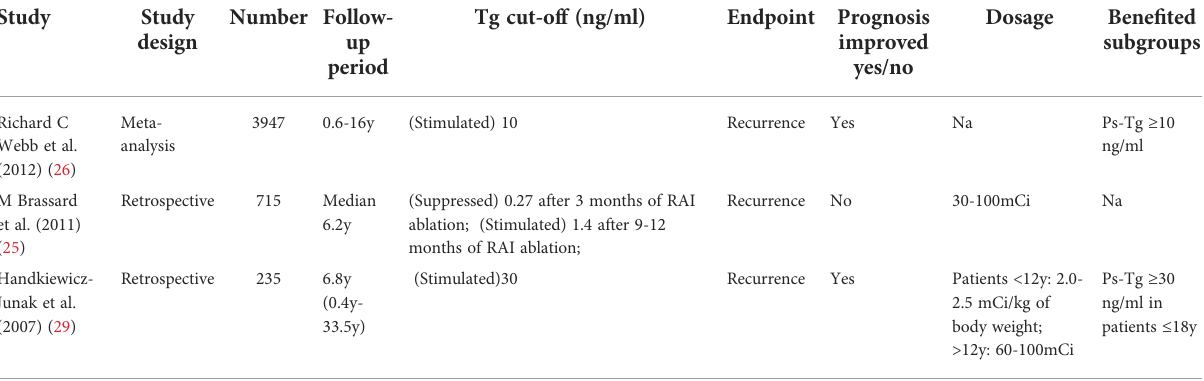
TABLE 3 Clinical outcomes of postoperative disease status guided